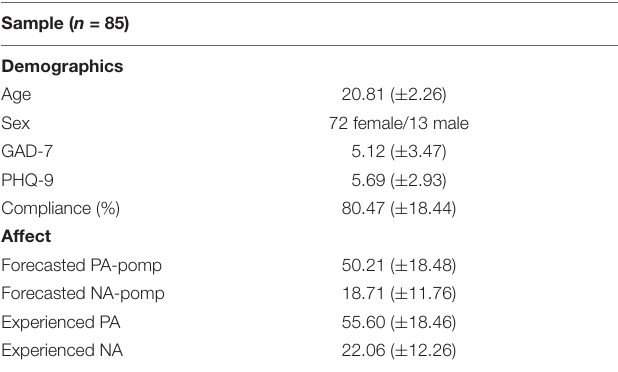
TABLE 2 | Detailed information about the recruited sample and affect measures (GAD-7: Generalized Anxiety Disorder; PHQ-9: Patient Health